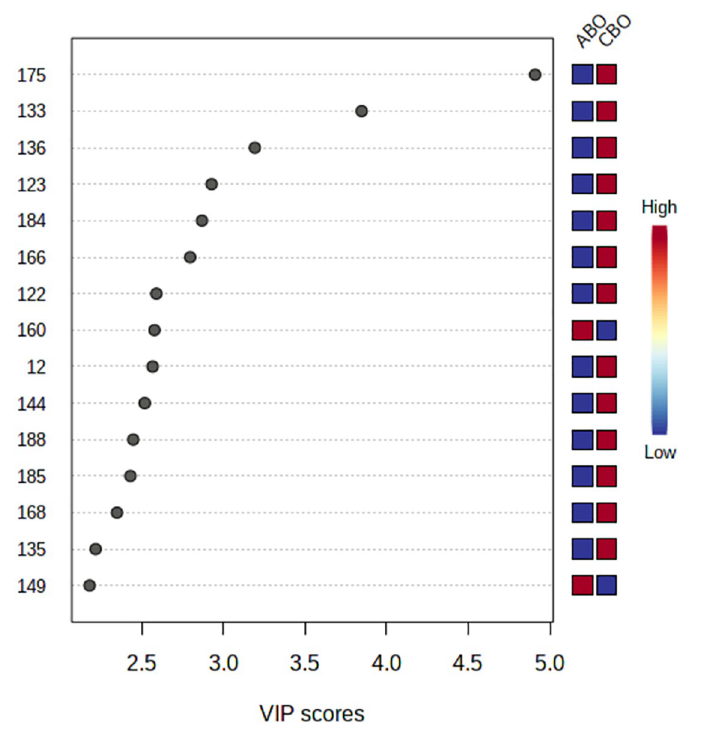
Fig 6. Important features identified by